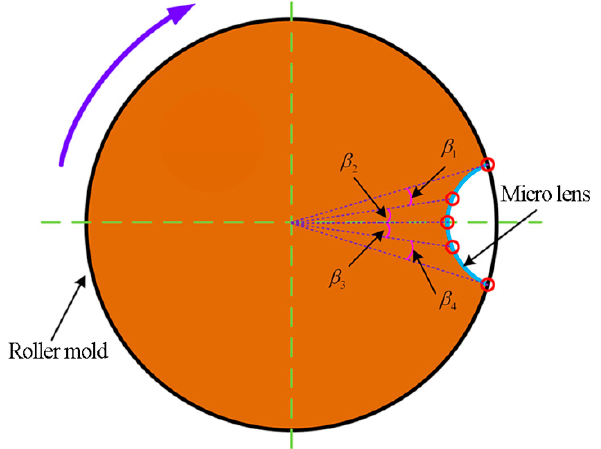
Figure 3. The equal-arc method.